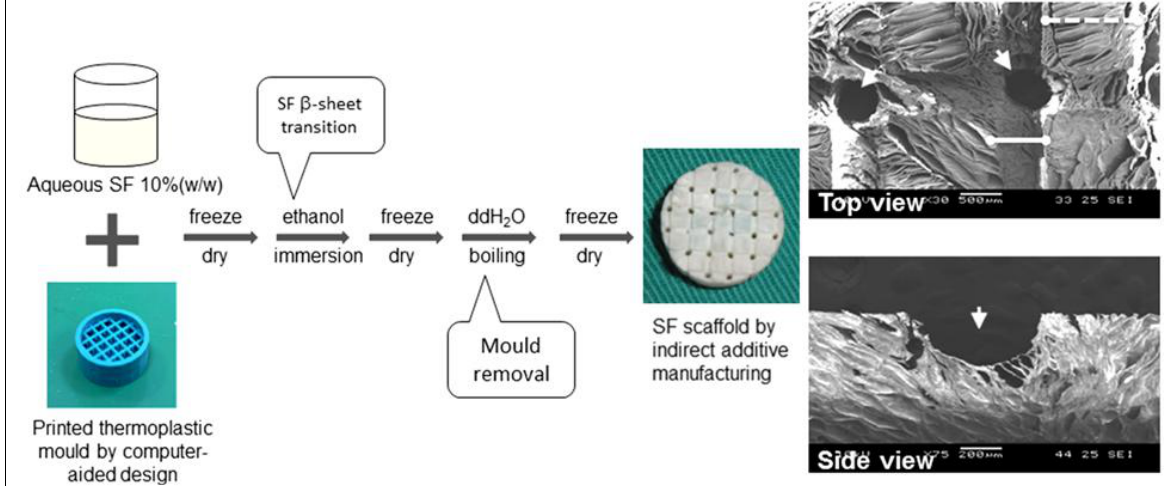
Figure 1. A printed thermoplastic mold through computer-aided design was first manufactured and a silk fibroin (SF) scaffold was obtained using the indirect additive manufacturing technique. The top view (bar = 500 µm) and side view (bar = 200 µm) of the circled area in the SF scaffold by scanning electron microscopy are shown. Arrowheads indicate penetrating channels. Solid and dotted lines demonstrate channel and inter-channel regions,